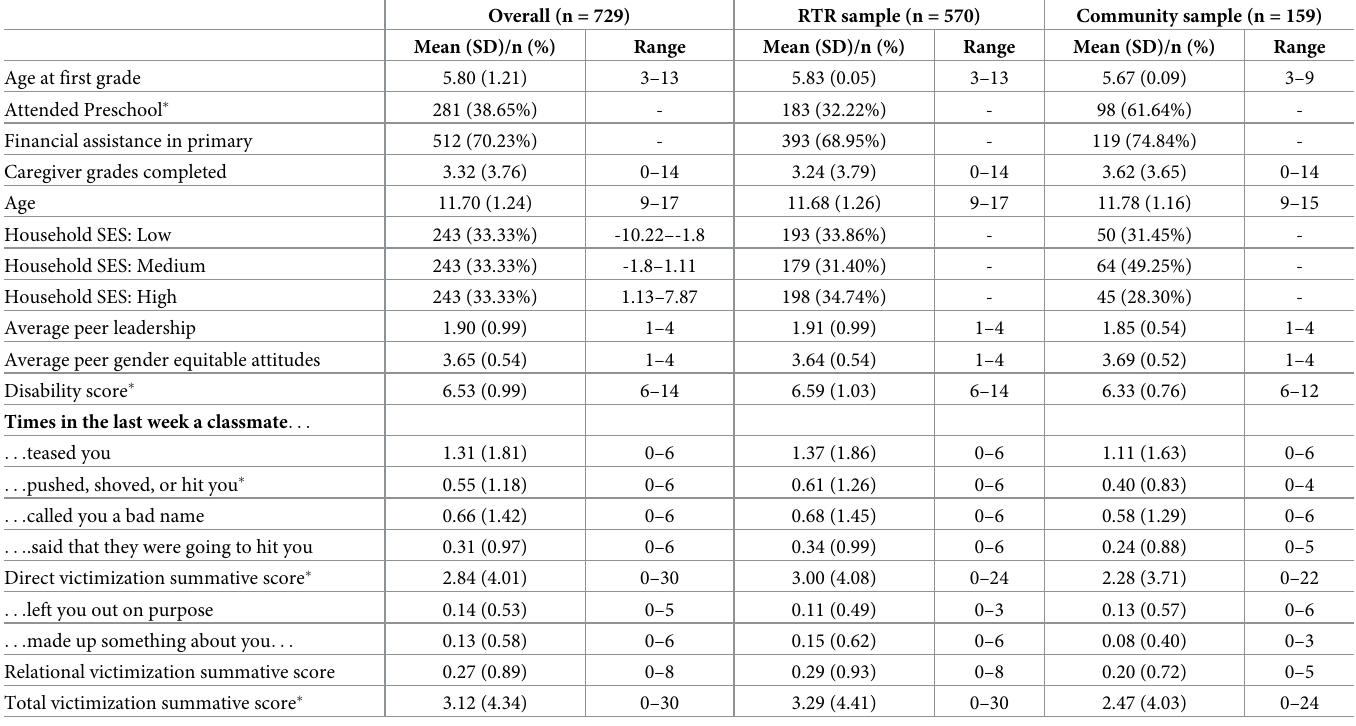
Table 2. Characteristics of adolescent girls (N = 729), Nuwakot and Tanahun districts, Nepal 2018.